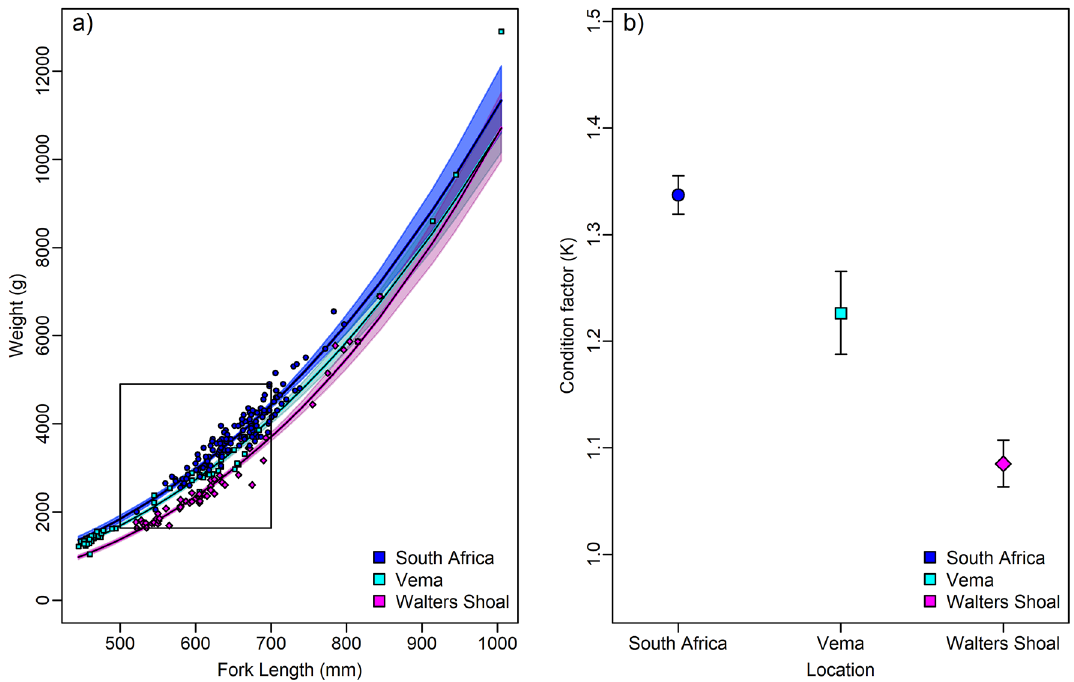
Figure 3. ( a ) Observed (symbols) and predicted (solid lines) length–weight relationships and ( b ) expected mean values of the condition factor K for yellowtail from sampling localities from South Africa, Vema and Walters Shoal sampling localities. The box highlights the size classes of 500 to 700 mm FL fish that were well represented for each sampling localities and used calculate the condition factor. Colour coded translucent areas ( a ) and error bars ( b ) denote the 95% confidence intervals the respective sampling locality. Differences in the colour gradients of shaded areas ( a ) result from overlaps in 95% confidence areas.